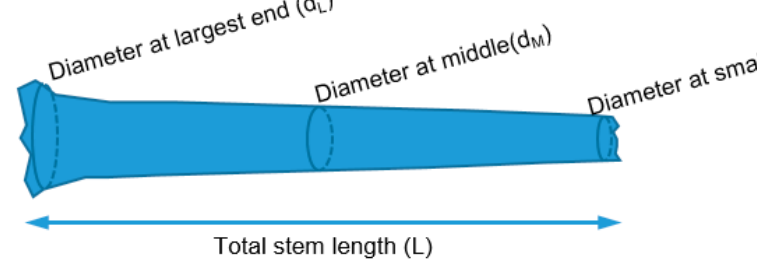
Figure A3. Measuring volume of fallen dead trees (logs).